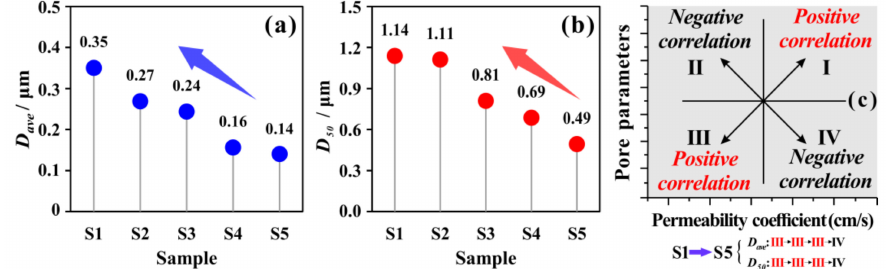
Figure 11. ( a , b ) Micropore parameters of soil samples in different reclamation areas; ( c ) overall change pattern of PC and other variables.